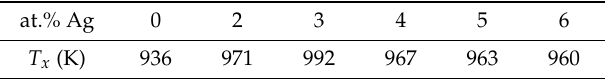
Figure 2. DSC scans of as-cast (Ti 35.2 Zr 43.8 Ni 21 ) 100 − x Ag x alloys upon heating with a rate of 10 K / min. A peak temperature on the first crystallization and solidus and liquidus temperatures were marked by T x , T s , and T l , respectively. Table 1. Peak temperatures ( T x ) on the first endothermic event. The measurement was conducted 2 times and then the temperature difference is less than 2 K at each composition.